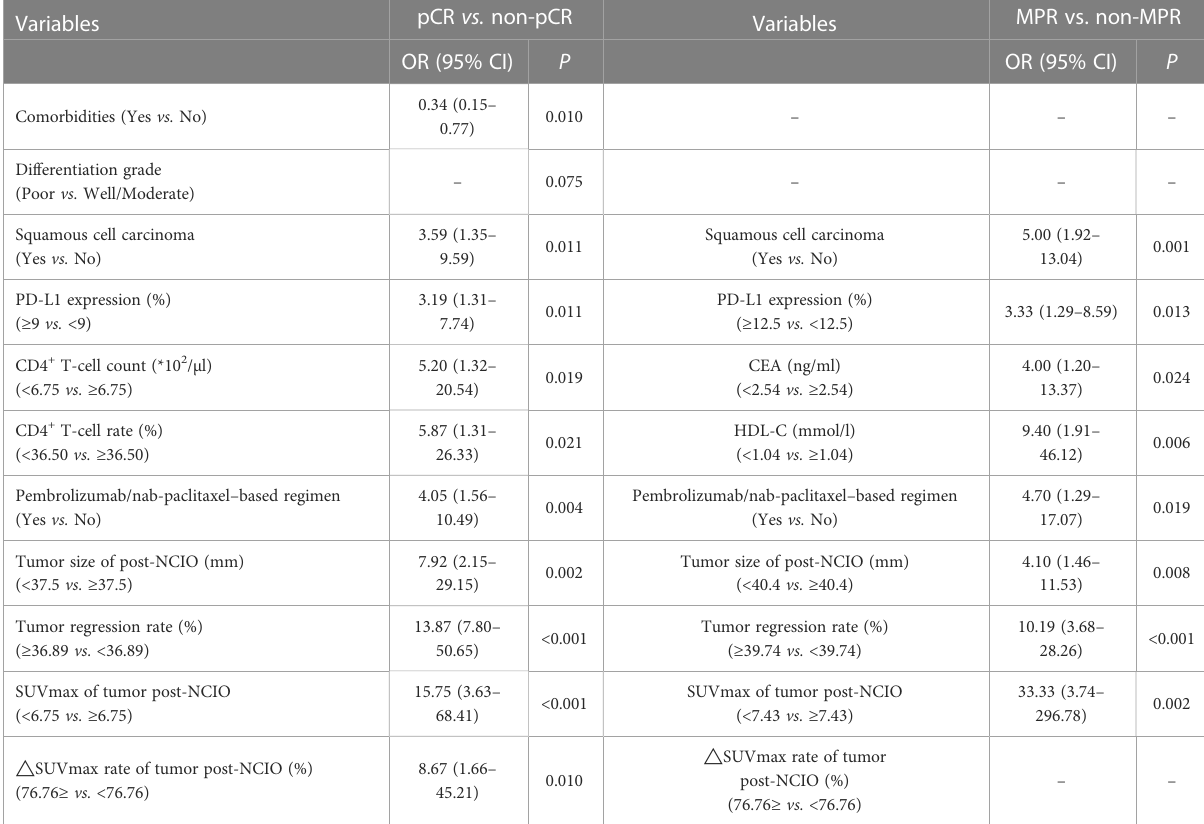
PD-L1:programmeddeathreceptor-1ligand;CEA,carcinoembryonicantigen;HDL-C,high-densitylipoproteincholesterol;ICIs,immunecheckpointinhibitors;SUV,standardizeduptake value; △ SUVmax = SUVmax of pre – NCIO-SUVmax of